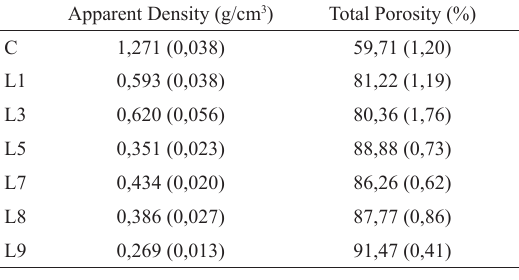
Table 3: Apparent Density and Total Porosity of foamed CaP cement samples. The standard deviation values are in parentheses. Apparent Density (g/cm 3 )